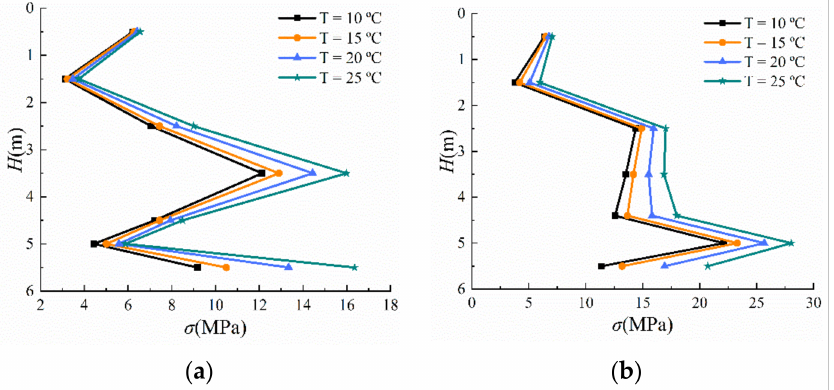
Figure 17. Stress-temperature relationship curve of the ( a ) rigid panel 1, ( b ) rigid panel